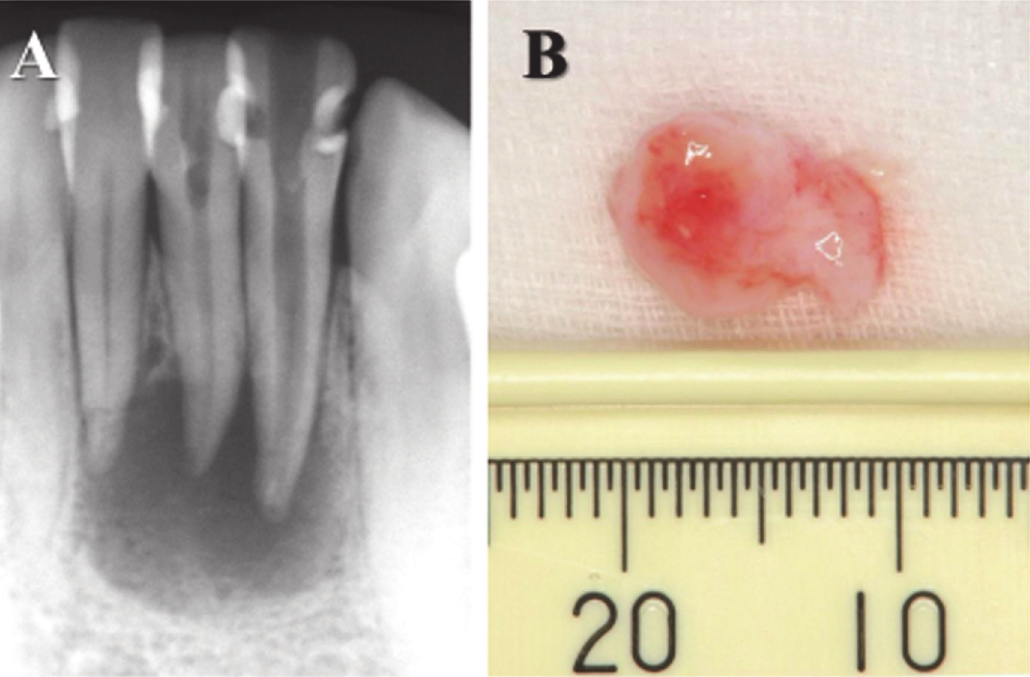
Fig 1. Specimens used in this study. (A) X-ray observation of periapical lesions caused at lower incisal teeth. Radiolucency around the apex showed alveolar bone resorption. (B) Periapical lesion surgically removed from a patient showing at